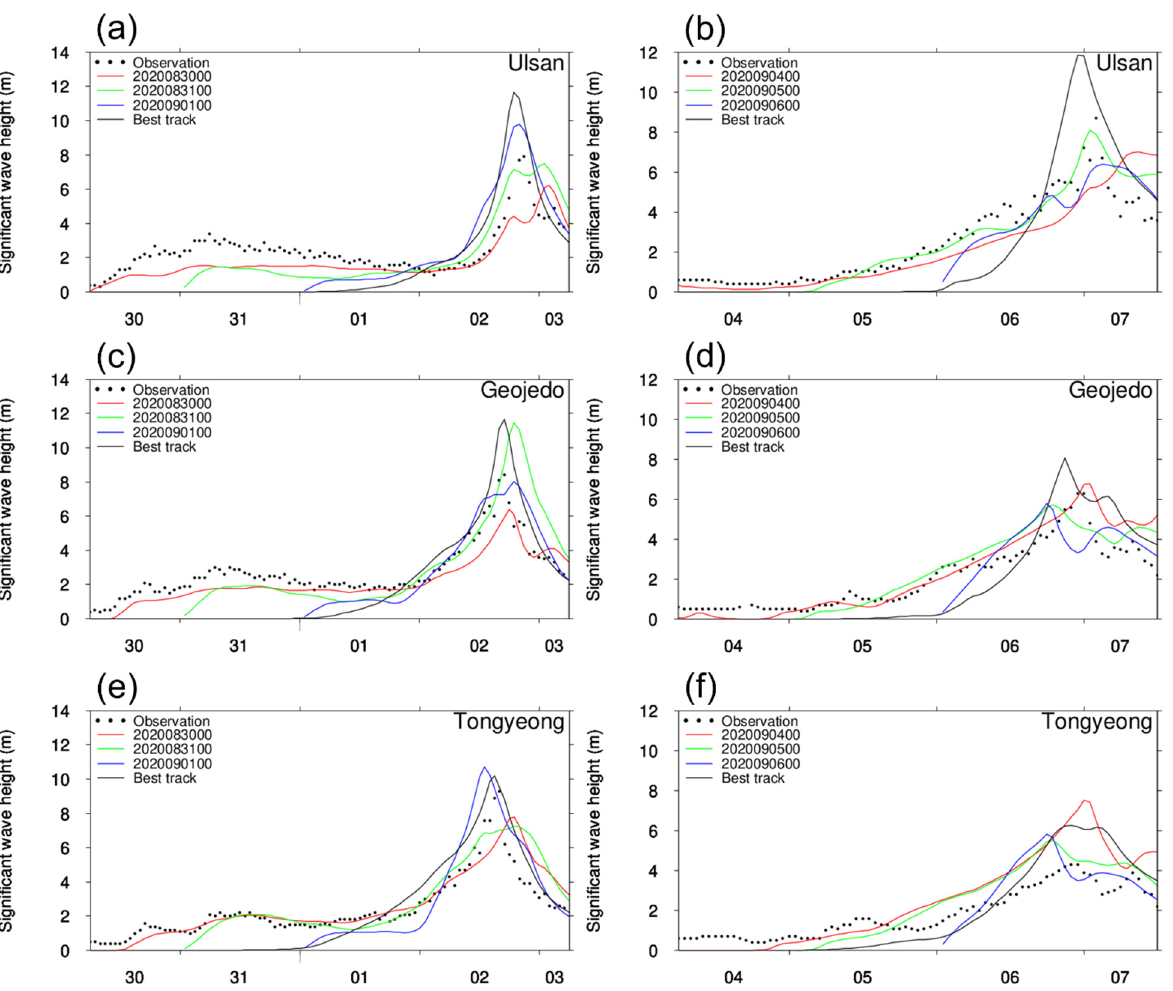
Figure 7. Comparison of the MPAS forecast and the hindcast with the moored buoy observations (Ulsan, Geojedo, and Tongyeong) of significant wave height for typhoons Maysak ( a , c , e ) and Haishen ( b , d , f ). Here, the x -axis indicates the time with the date of the simulation period, and the interval of observation data is one